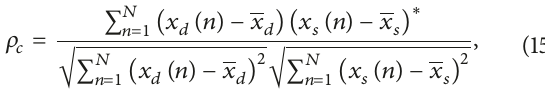
clutter can therefore not be deduced from these above